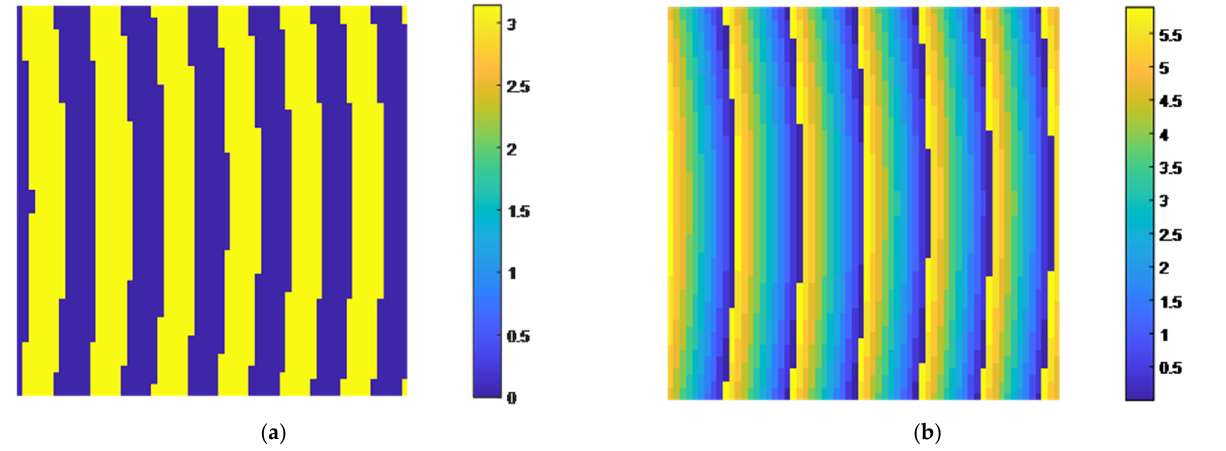
Figure 2. RIS panel phase distribution. ( a ) RIS panel phase distribution for a 1-bit single-polarized panel; ( b ) RIS panel phase distribution for a 4-bit dual-polarized panel.